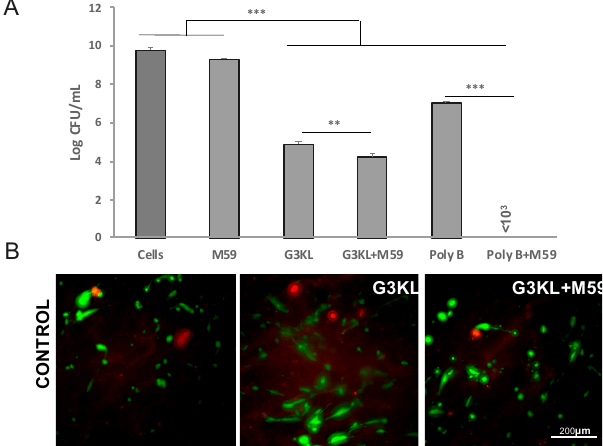
Figure 5. Assessment of the antibacterial effect and cytocompatibility of G3KL incorporated into a collagen-based solid matrix. ( A ) CFUs retrieved under the collagen matrix incorporating only progenitor cells, M59 (10 µM), G3KL (100 µg/mL), M59 (10 µM) and G3KL (100 µg/mL), polymyxin B (PolyB; 12.5 µg/mL), PolyB (12.5 µg/mL) and M59 (10 µM). ( B ) Live/Dead cell viability assay for progenitor cells seeded onto collagen matrix incorporating G3KL (100 µg/mL), or a combination of M59 (10 µM) and G3KL (100 µg/mL). Live cells are stained green and dead cells are stained red. Data are presented as the means ± SD ( n = 3). p values were determined by unpaired Student’s test. ** p ≤ 0.01 *** p ≤